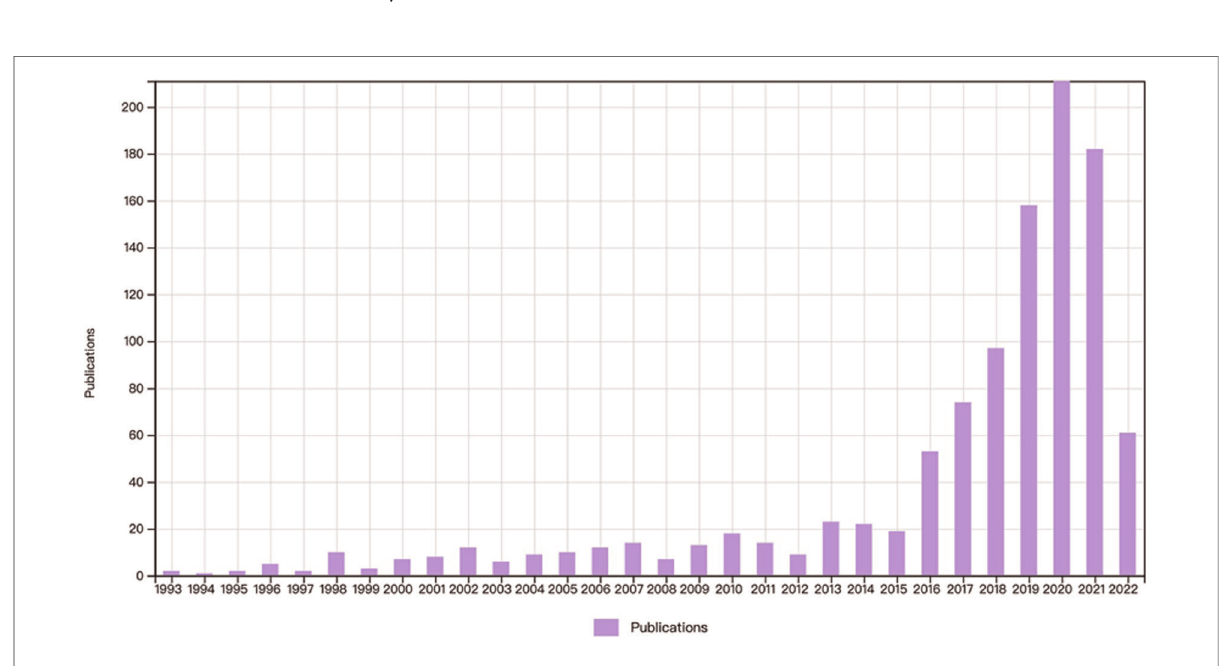
FIGURE 1 The annual trends of publications and